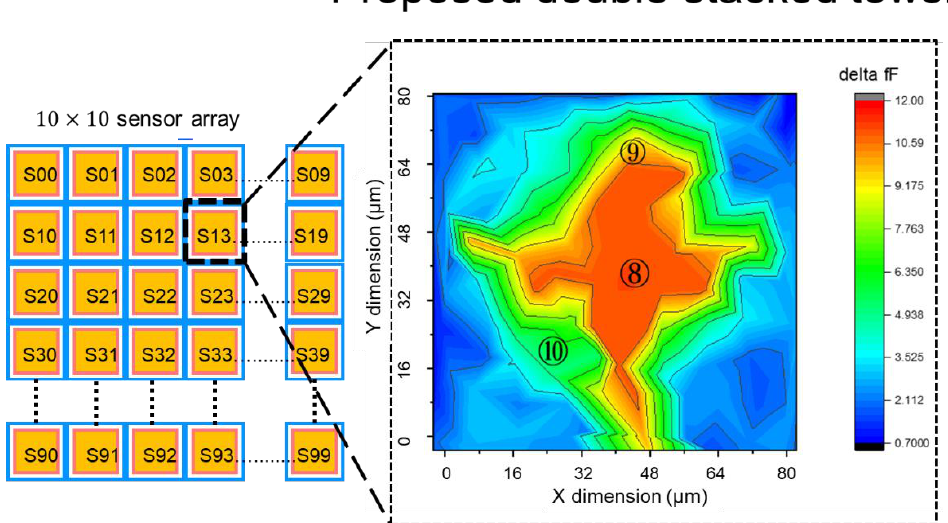
Figure 8. Capacitance change contour plot for proposed doubled stack tower in a pixel. The contour plot represents the capacitance change absorbed by ion-binding. The area noted in ⑧ _RED is most sensitivity zone (hot zone), and noted in ⑨ _YELLOW and ⑩ _GREEN are secondly and thirdly, in respectively. The capacitance change in ⑧ _RED, ⑨ _YELLOW, ⑩ _GREEN account for 67% of a pixel.